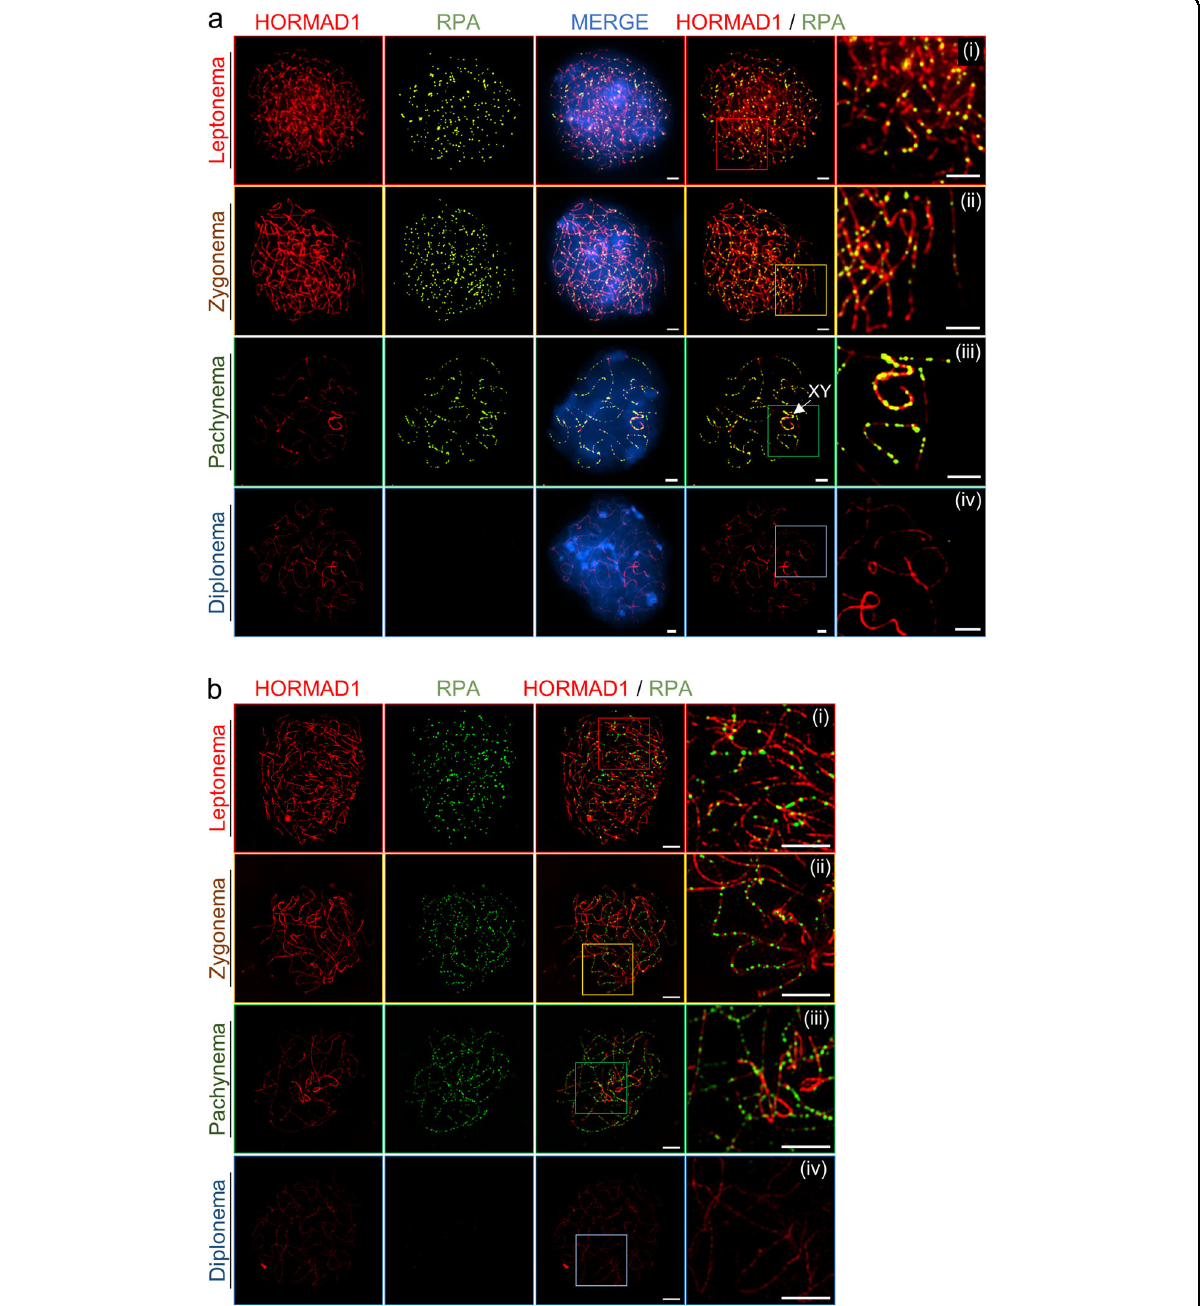
Fig. 4 Distribution of replication protein A foci and HORMAD1 in prophase I. Imaging analysis of distribution of RPA and HORMAD1 in wild- type spermatocytes during prophase I of meiosis. Nuclei were simultaneously immunostained with anti-RPA (green)/anti-HORMAD1 (red) and analyzed by conventional microscopy ( a ) and super-resolution microscopy ( b ) in the prophase stages leptonema (i), zygonema (ii), pachynema (iii), and diplonema (iv). Bars represent 2.5 μ